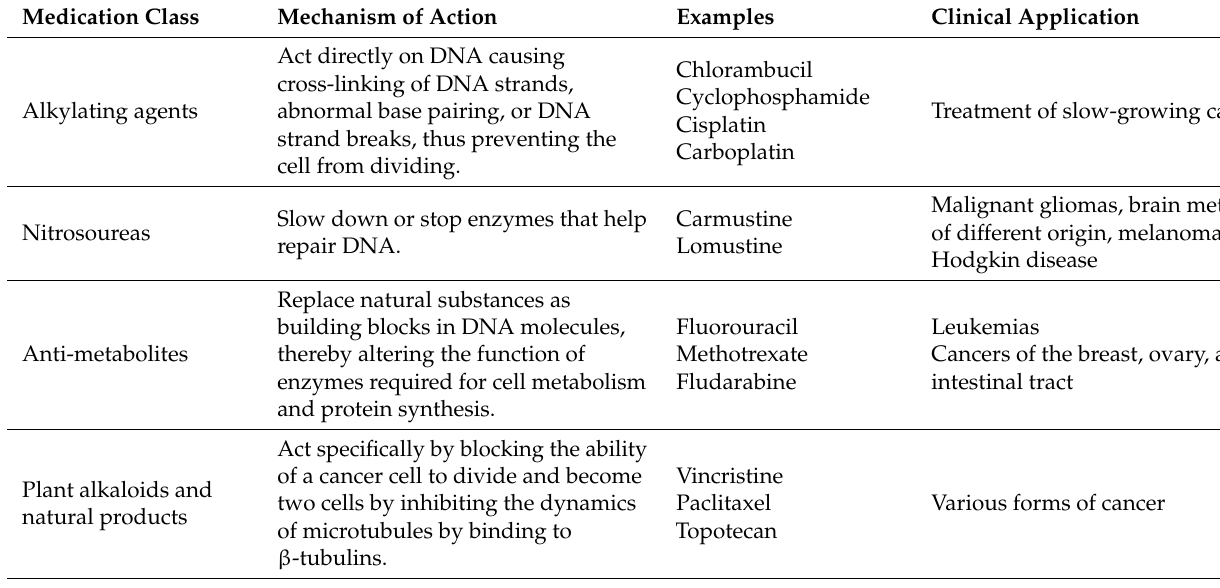
Table 1. Types of chemotherapy medication